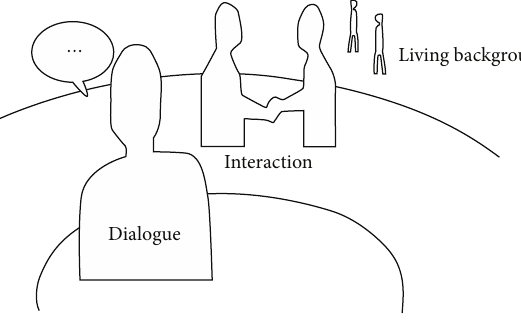
Figure 12: Level of interaction